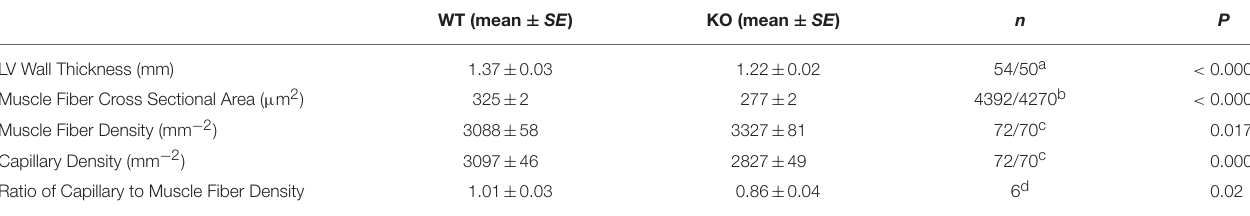
TABLE 1 | Morphological parameters of left ventricular cardiac muscle of hearts of WT and AQP1-KO mice.